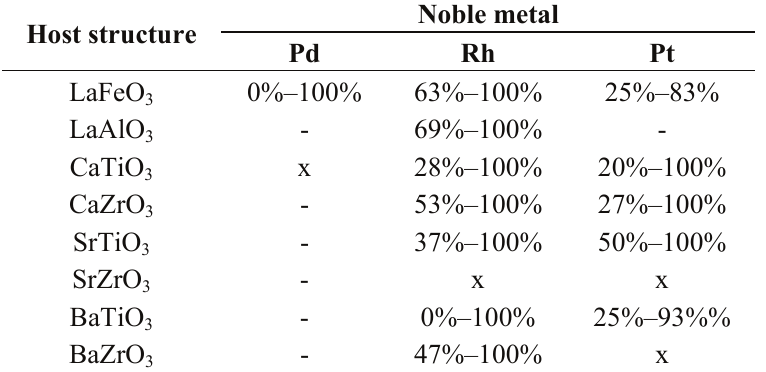
Table 1. Proportion of noble metal in A B solid solution with the host structure under reducing (lower value) or oxidative (upper value) atmosphere (“-” indicates that no data is available; “x” indicates that the precious metal and the perovskite do not form a solid solution). Adapted from Tanaka et al.